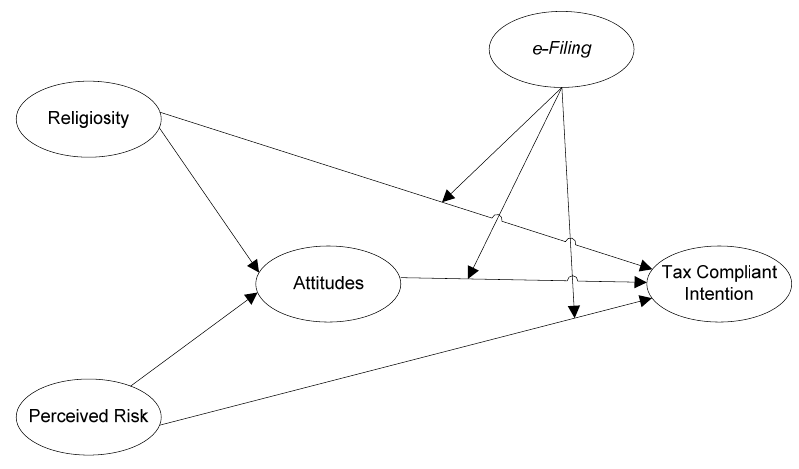
Figure 1. Conceptual Framework.